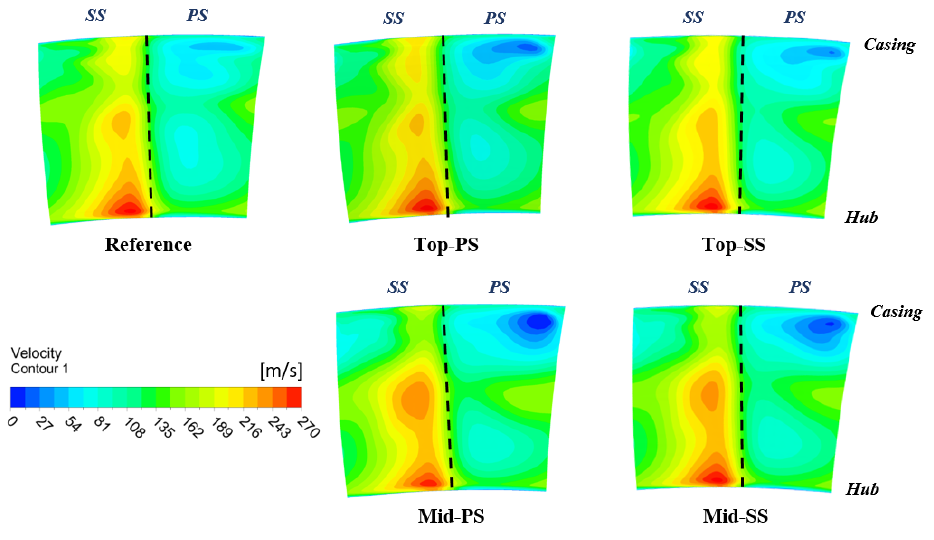
Figure 11. Velocity contours at the entrance of the S 2 vane.